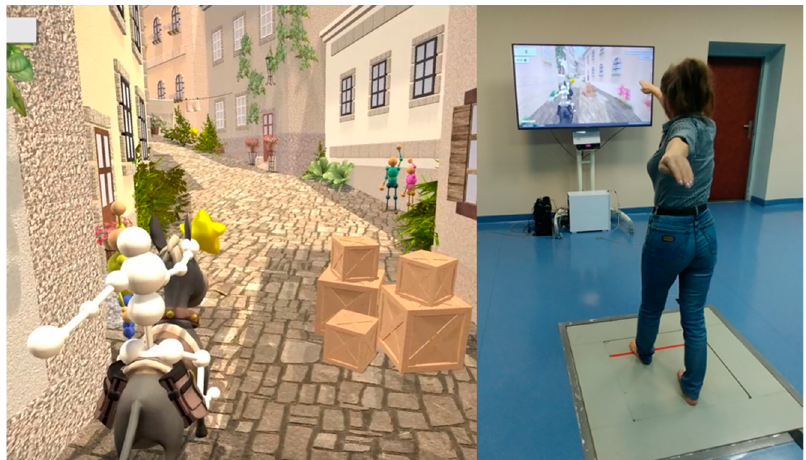
Figure 1. Virtual reality exergaming system setup.